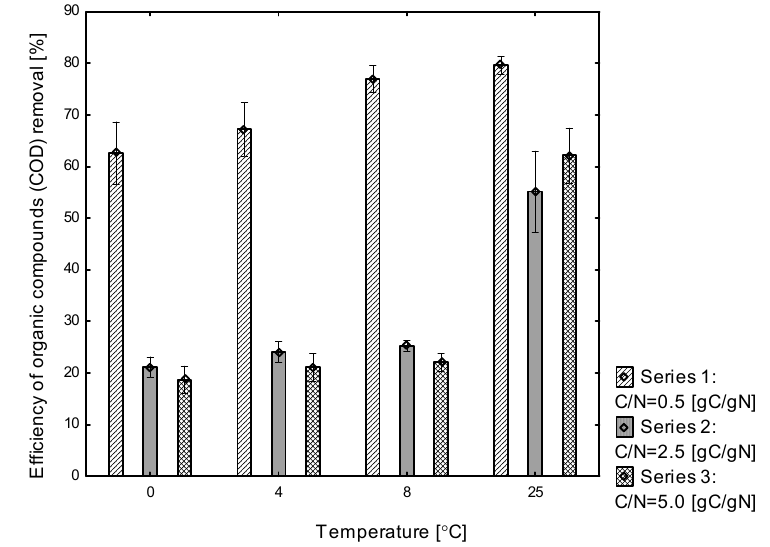
Figure 8. Efficiency of organic compound removal depending on the C/N ratio.